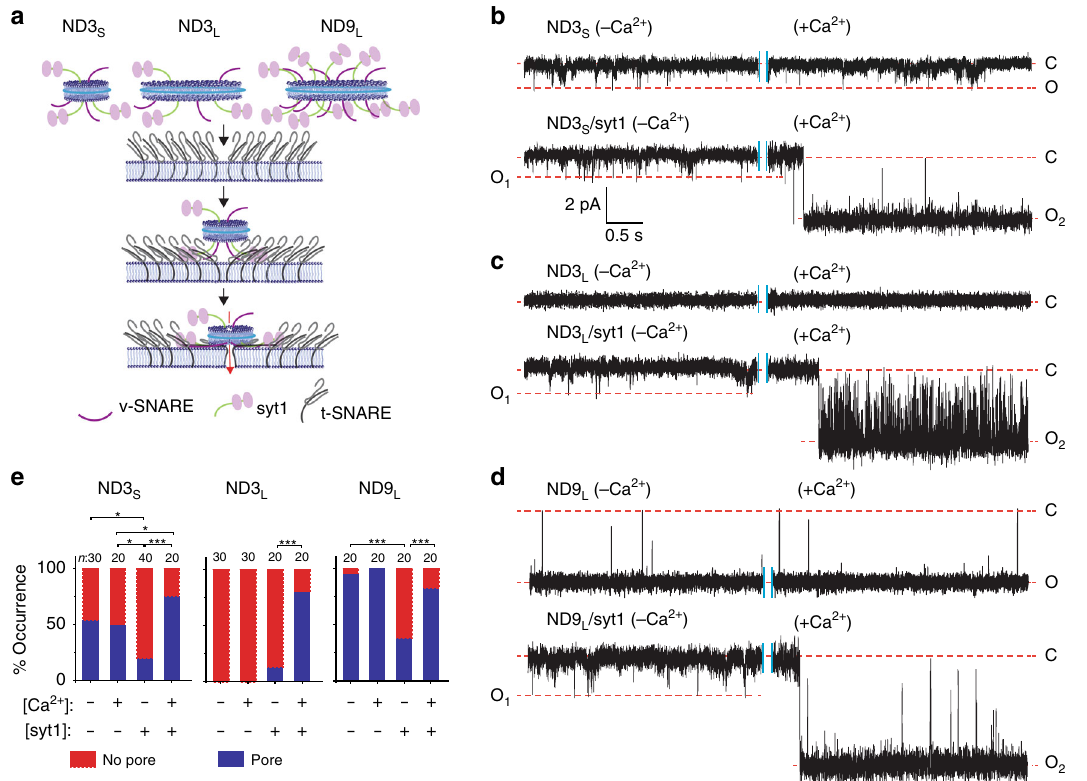
Fig. 1 Syt1 regulation of single fusion pores measured via planar lipid bilayer electrophysiology. a Illustration of the nanodisc-black lipid membrane (ND- BLM) system, drawn to scale, indicating the different ND preparations used in this study. The number indicates the syb2/syt1 copy number (1:1) per ND; the subscript S stands for small, 13 nm, NDs and the subscript L stands for large, 30 nm, NDs. Traces of single pores with/without syt1 are shown for ND3 S ( b ), ND3 L ( c ), and ND9 L ( d ). In each trace, minus ( − ) Ca 2 + contains 1 mM BAPTA (in all bilayer recording experiments in this study) and plus ( + ) Ca 2 + contains 500 µ M [Ca 2 + ] free . Closed (C) and open (O) states are shown; the current and time scale, for all traces, is shown in the inset in b . O 1 and O 2 indicate open state currents obtained before and after addition of Ca 2 + , respectively. e Fraction of trials in which a fusion pore was detected, plotted as percentage of occurrence. ND3 S , ND3 L , and ND9 L , in the presence ( + ) or absence ( − ) of Ca 2 + and in the presence ( + ) and absence ( − ) of syt1 were compared. Three independent sets of NDs of each type were used, and the total number of measurements obtained under each condition ( n ) is indicated. Pearson ’ s χ 2 analysis of pores formed by ND3 S , ND3 L , and ND9 L was performed; * p < 0.05, *** p <